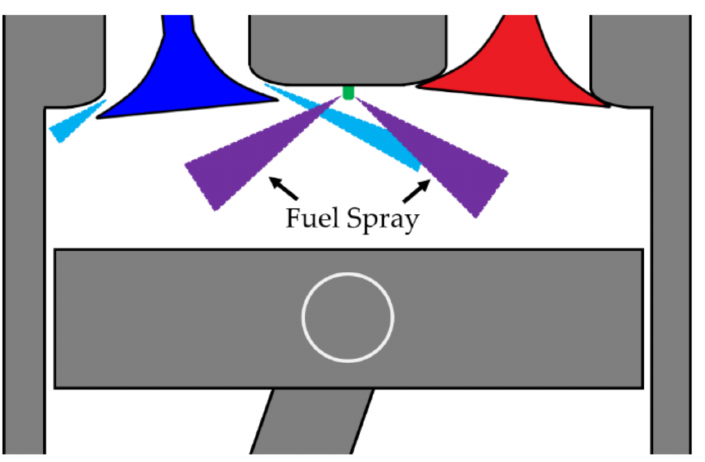
Figure 5. Simple 2D diagram of combustion chamber with fuel and air jets in